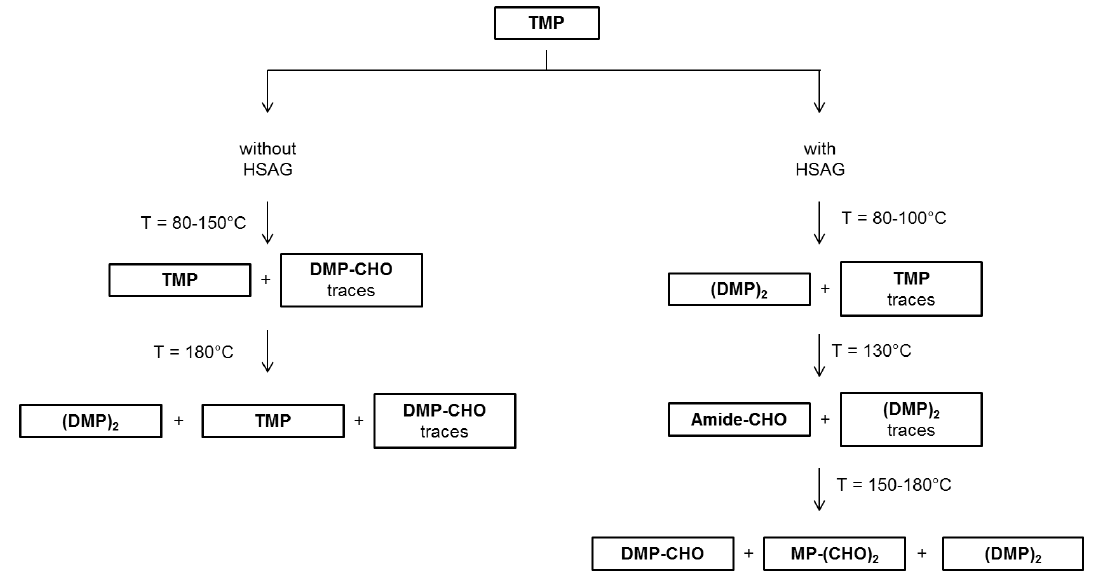
Figure 8. Scheme for the formation of TMP derivatives after thermal treatments at different temperatures, in the absence and in the presence of a catalytic amount of HSAG, from 1 H NMR analysis of the liquid fraction.